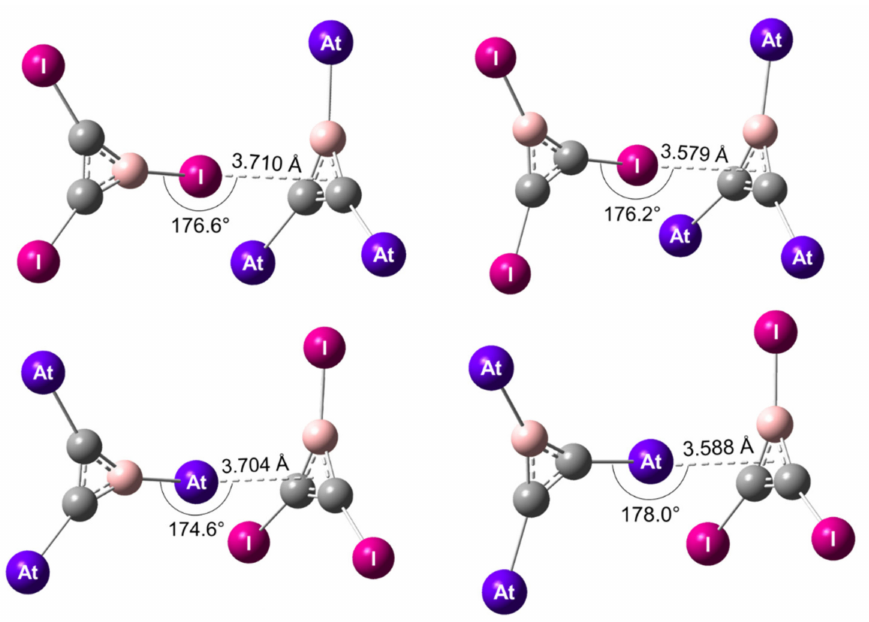
Figure 3. Structures of the XB complexes formed by C 2 BI 3 and C 2 BAt 3 at the 2c-PW6B95D3/TZVPPD level of theory. The XB interactions mediated by iodine (X = I, Y = At) are displayed on top and the ones mediated by astatine (X = At, Y = I) on the